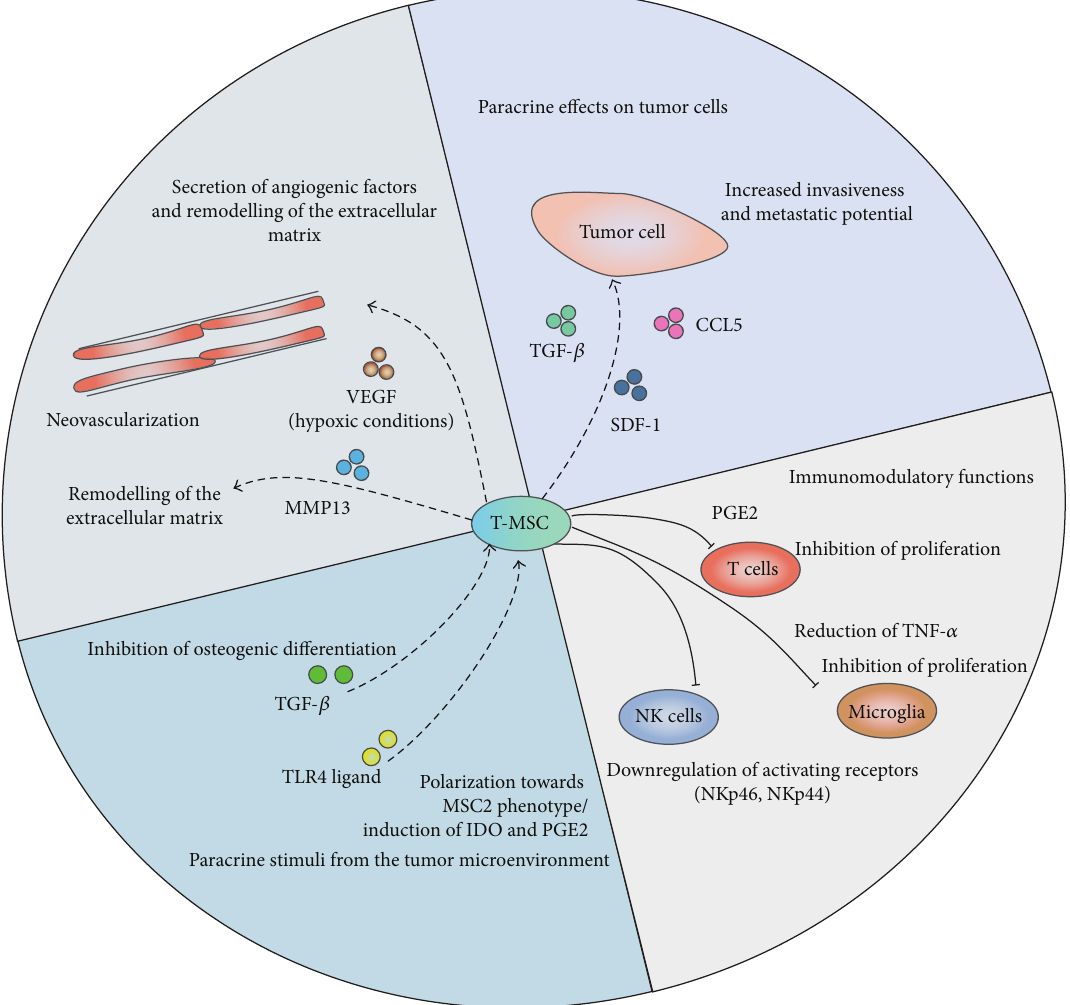
Figure 1: Interplay between T-MSC and the tumor